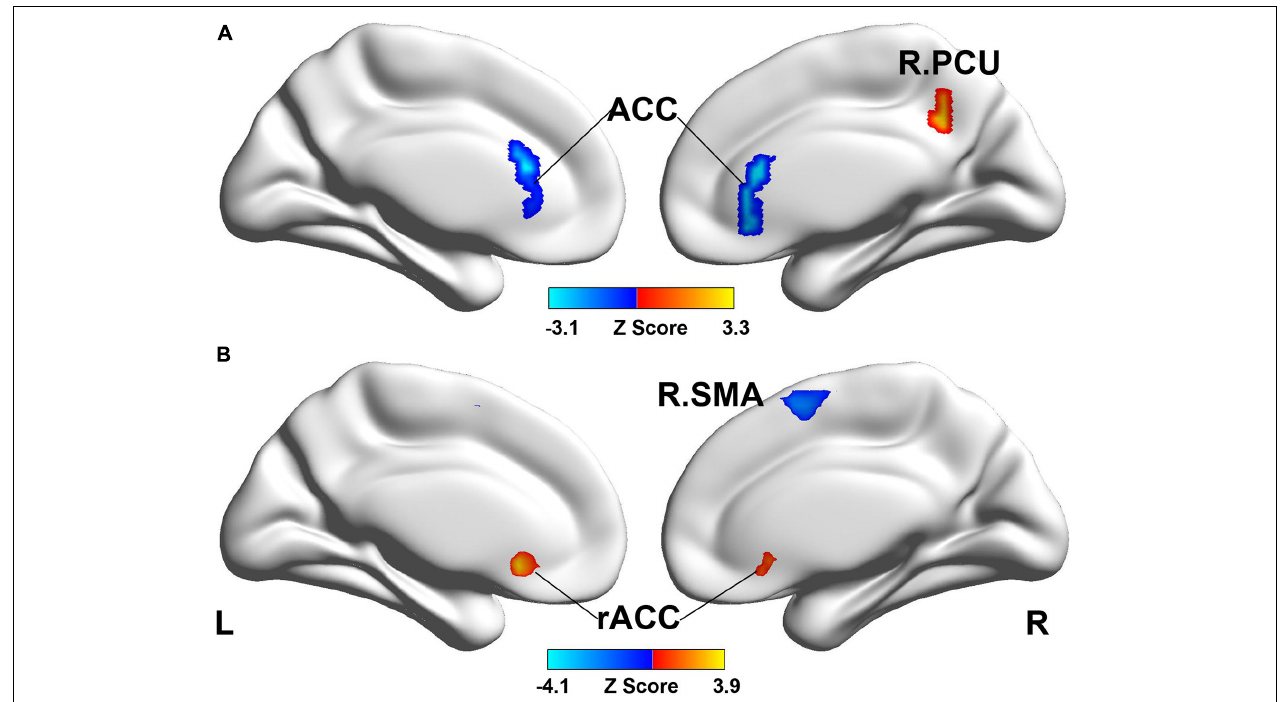
FIGURE 3 | Brain activity in different conditions between real vs. sham treatment group. (A) The brain activity difference of retention condition and twirling condition between real vs. sham acupuncture treatment. (B) The brain activity difference of twirling vs. retention condition between real vs. sham acupuncture treatment. ACC, anterior cingulate cortex; PCU, precuneus; SMA, supplemental motor area; rACC, rostral anterior cingulate